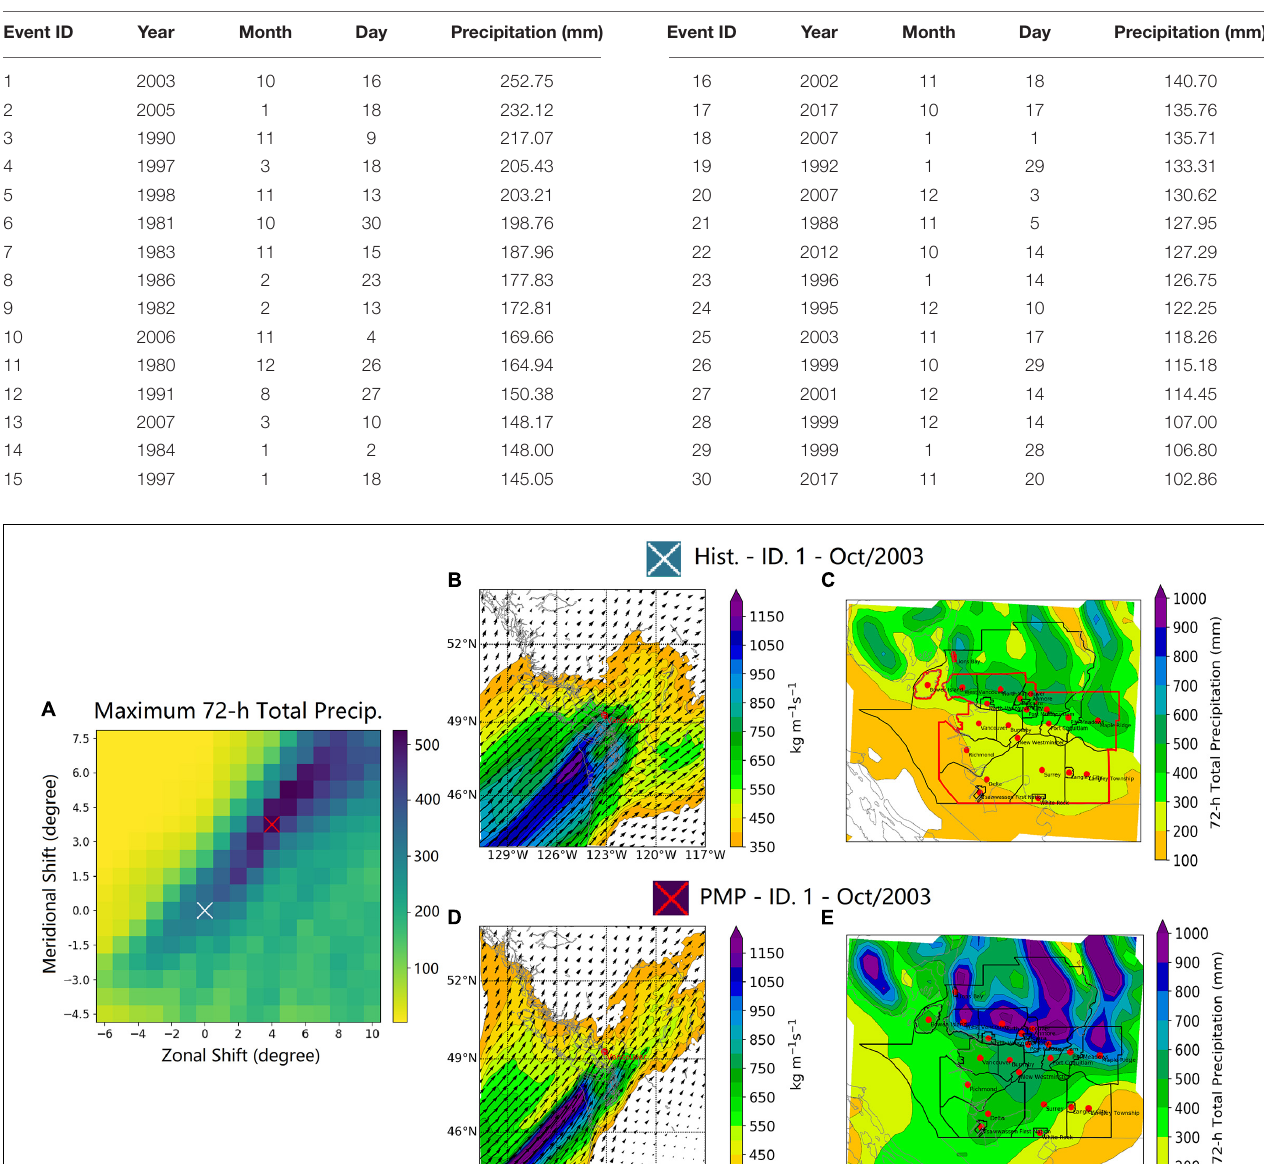
TABLE 1 | Date and regional average of 72-h total precipitation for the 30 most intense extreme precipitation events associated with ARs affecting Metro Vancouver based on the Daymet dataset.